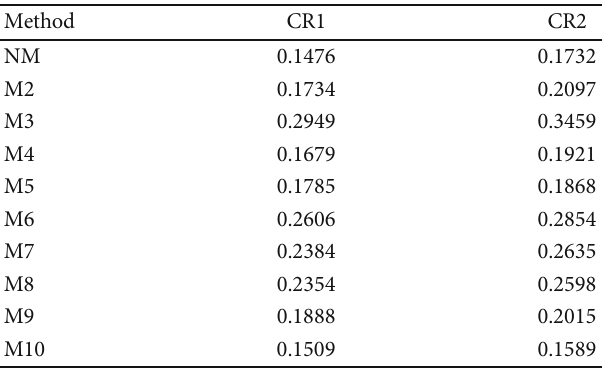
Table 19: Values of FJC1 and FJC2 for methods 1-11 to solve Test Problem 5, by the algorithms of the third category for n = 100 .